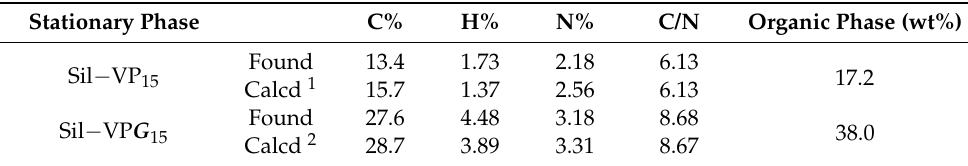
Table 1. Elemental analysis of Sil − VP 15 and Sil − VP G 15 .